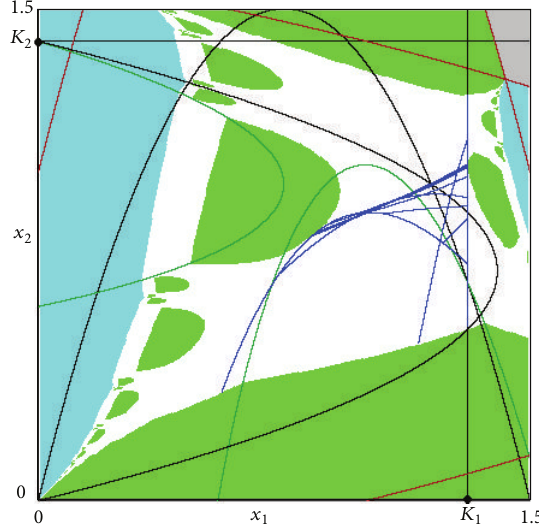
Figure 6: Parameters: 𝑁 1 = 1.5 , 𝑁 2 = 1.4 , 𝜏 1 = 𝜏 2 = 4 , 𝛾 1 = 𝛾 2 = 1 , = 1.31 , and 𝐾 = 1.4 . The green (resp., azure) region is the basin 𝐾 1 2 of attraction of the superstable equilibrium of segregation (𝐾 1 , 0) (resp., (0,𝐾 2 ) ), and the white region is the basin of attraction of the chaotic attractor depicted in